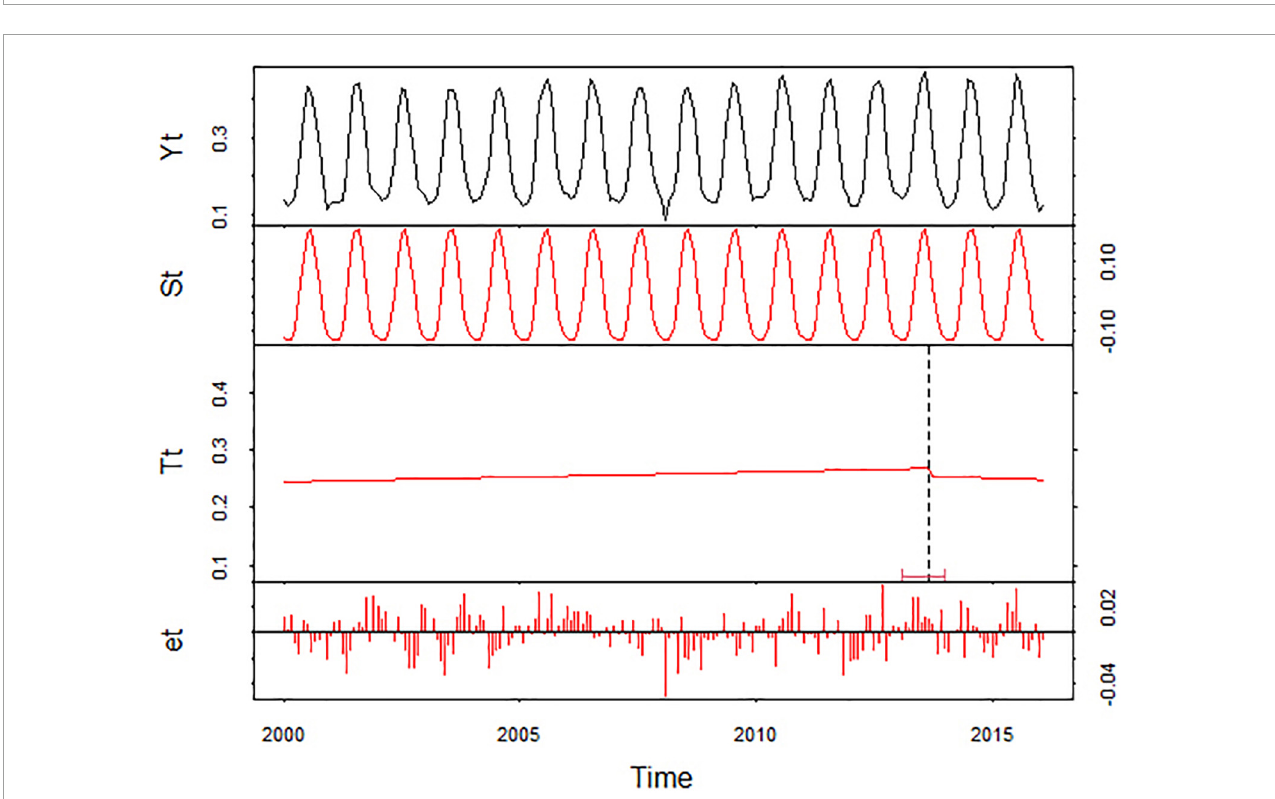
FIGURE3 Breaks for additive seasonal and trend (BFAST) breakdown of normalized difference vegetation index (NDVI) time series for the 2000–2015 period for alpine wetland vegetation in